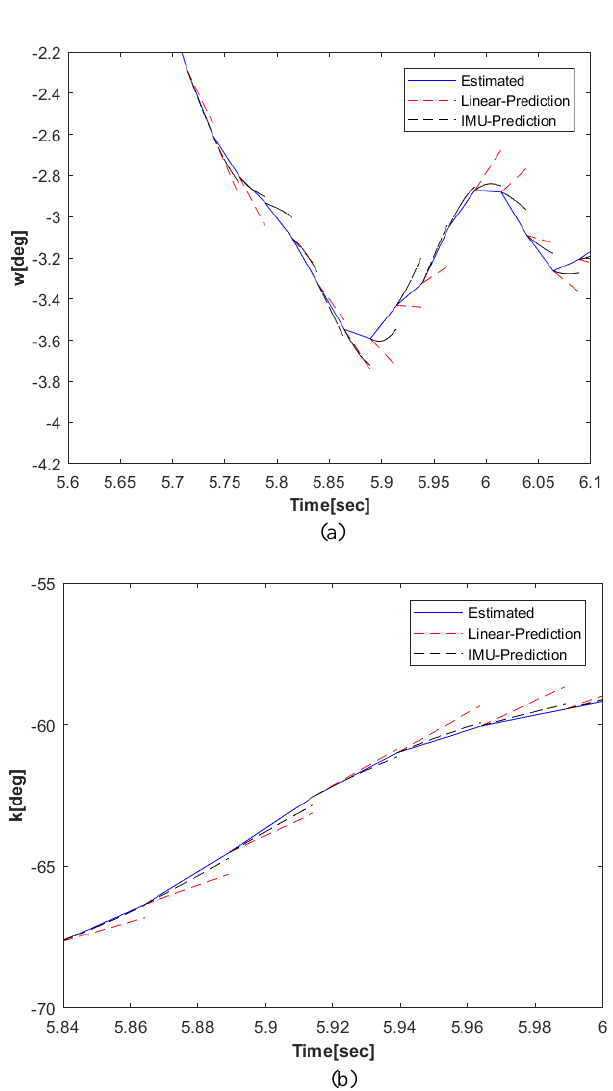
Figure 3. Part of the rotation angles (ω, κ ) trajectories. (a) for ω. (b) for κ . Each blue line connects the two estimated angles (ω, κ ) at the start and end of one local window (≈ 25 ms). The dashed black and red lines are the IMU and linear predictions of angle (ω, κ ), respectively.